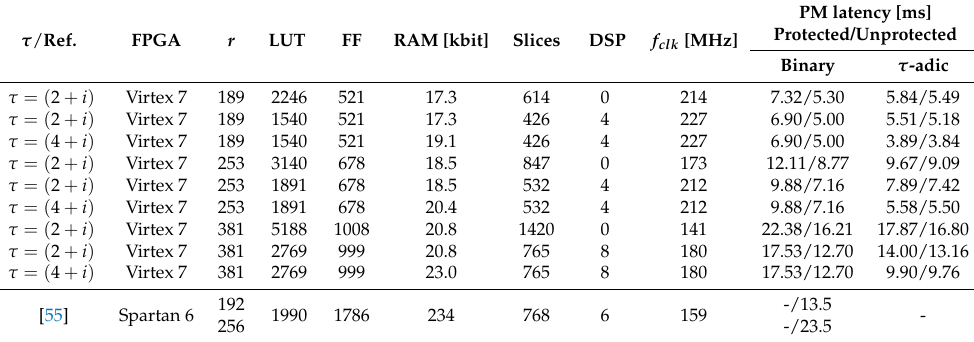
Table 4. Results and comparison with other area efficient